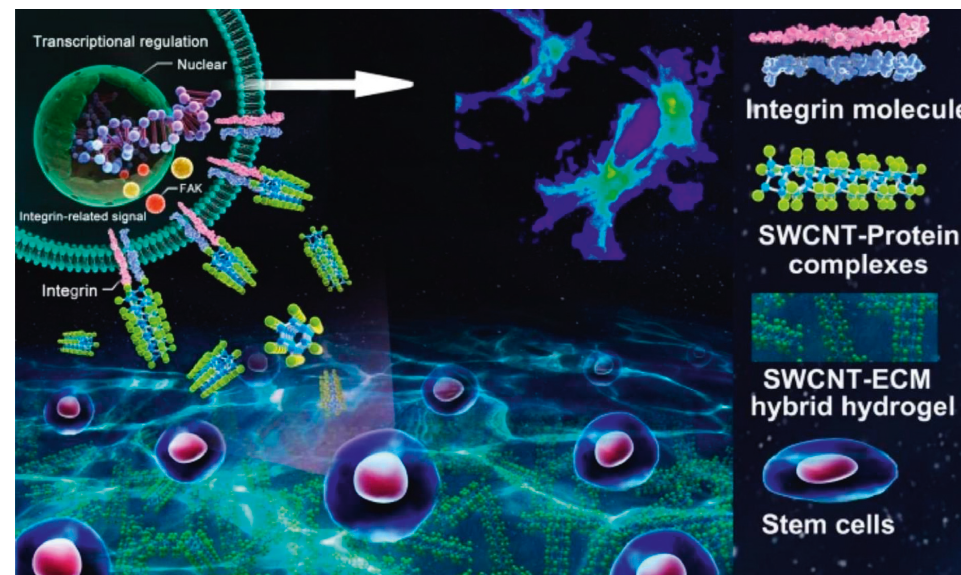
Figure 3: Conductive single-wall carbon nanotubes/extracellular matrix hybrid hydrogels promote the lineage-specific development of seeding cells for tissue repair through reconstructing an integrin-dependent niche